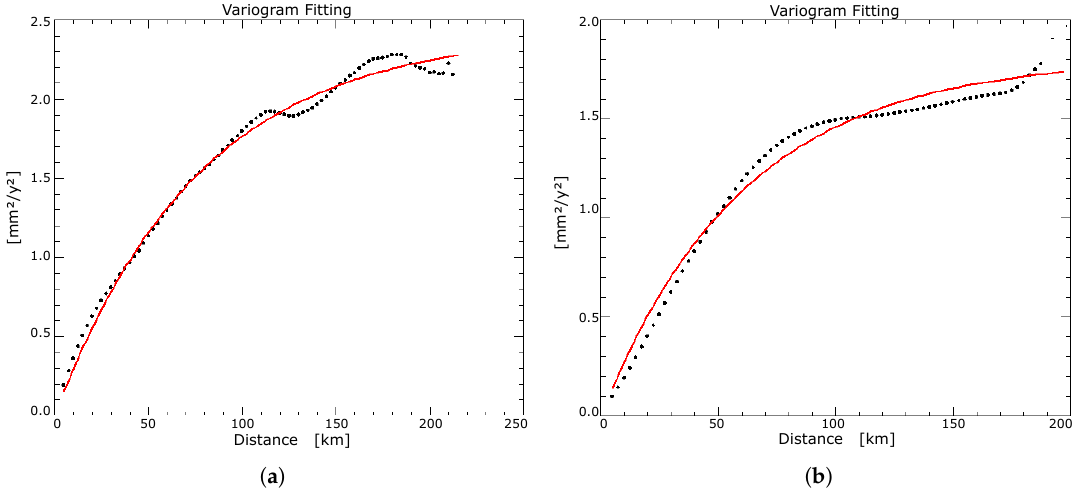
Figure 2. Examples of an exponential fitting of the deformation rate variograms. The black dots represent the estimated variogram and the bold red line represents the estimated model. The variograms in ( a ) and ( b ) refer to the stacks 123/2 and 123/3 of the North Anatolian Fault data set respectively , see Section